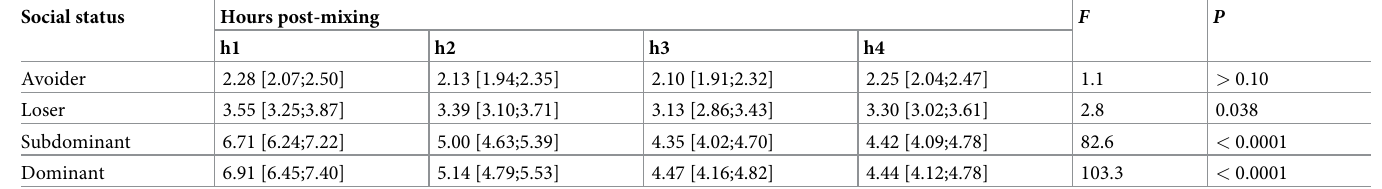
Table 2. Total number of reciprocal and non-reciprocal agonistic acts delivered and received by gestating sows across the first four hours post-mixing (on day 0) according to their social